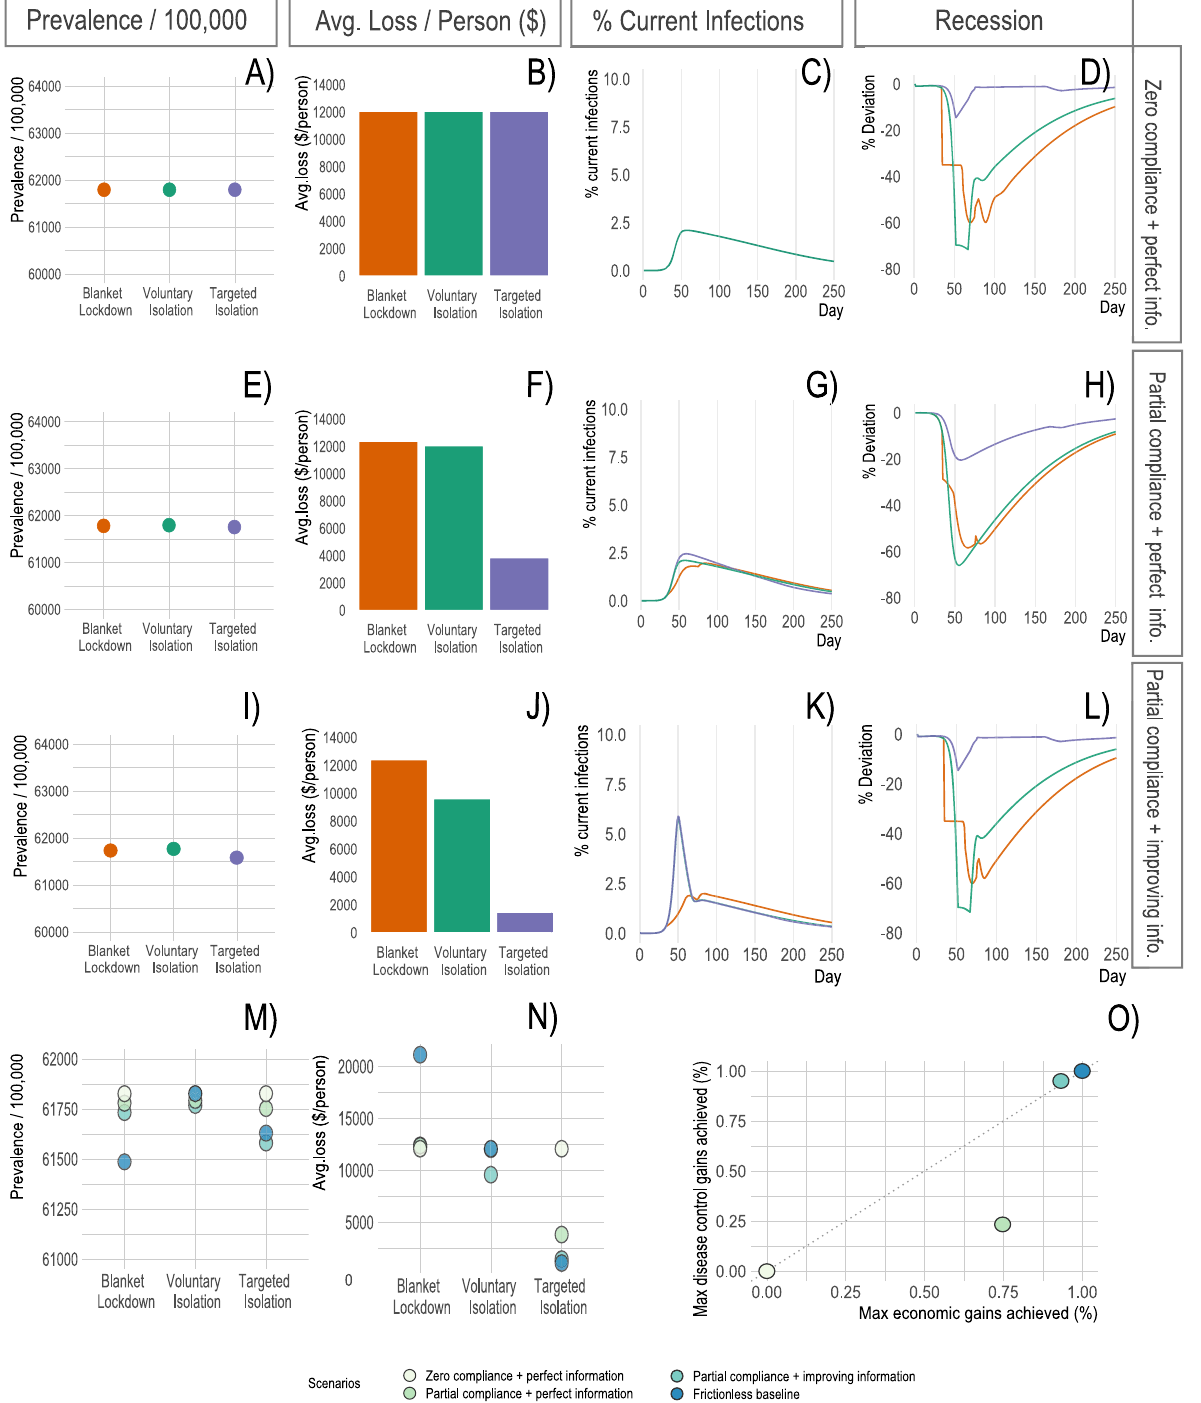
Fig. 5 Model outcomes with different compliance rates. A – D Key model outcomes under 0% compliance and no information frictions. E – H These outcomes under 75% compliance and no information frictions. I – L These outcomes when test quality linearly improves from 10% to 95% by day 75 and the test reporting lag reduces from 8 days to 5 days at day 60 then from 5 days to 3 days at day 75. M , N How disease-economy outcomes vary across these scenarios. O The disease-economy outcomes under these scenarios relative to the baseline in Fig. outcomes as infectious individuals act as susceptibles, solving the coordination failure. Taken together, our results provide qualitative insights into the importance of information quality, information timeliness, and compliance on the bene fi ts of relevant model parameters. The main functional form for the targeted isolation policies. contact function is assumed to be linear, such that additional